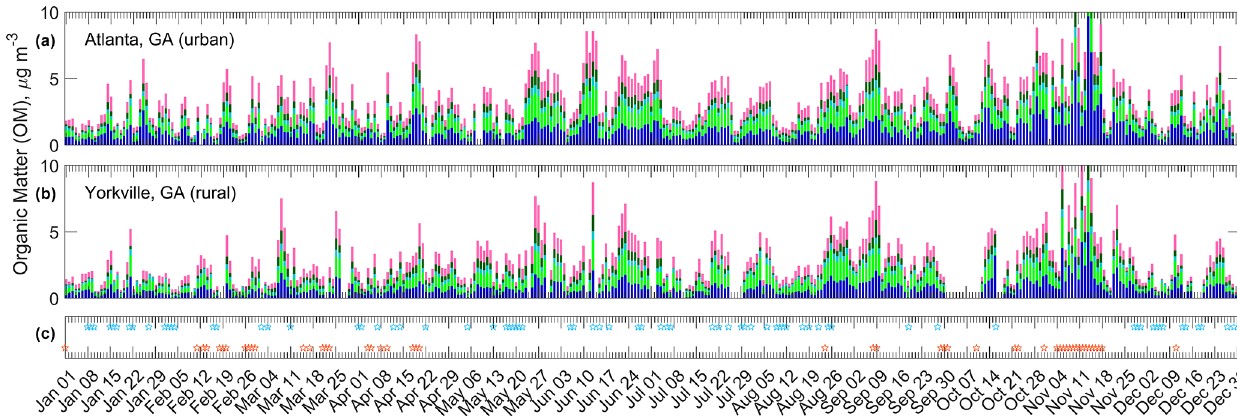
Figure 7. Absolute OM and FG concentrations during 2016 for the urban (a) and rural (b) Georgia sites. Some values (three at each site) extend beyond the vertical axis scale so that variation can be observed within low and typical OM concentration ranges. Events related to OM concentration dynamics are represented in (c) : precipitation events correspond to blue markers; fires correspond to orange markers. See Fig. 2 for legend FG